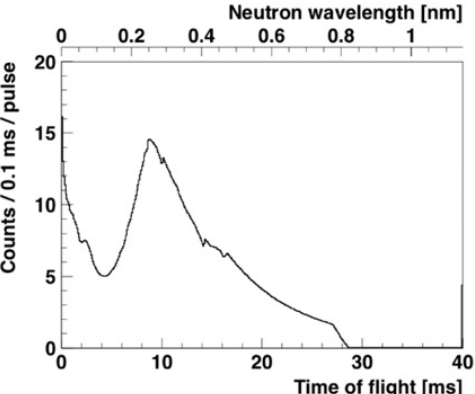
Figure 8. Neutron TOF spectrum measured using the inlet beam monitor at NOVA.